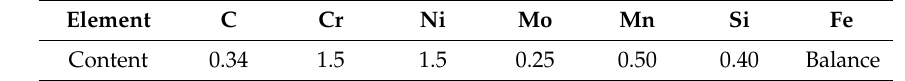
Figure 3. Geometric shape and size of the unrepaired plate. Table 1. Alloying composition of 34CrNiMo6 alloy (wt %).